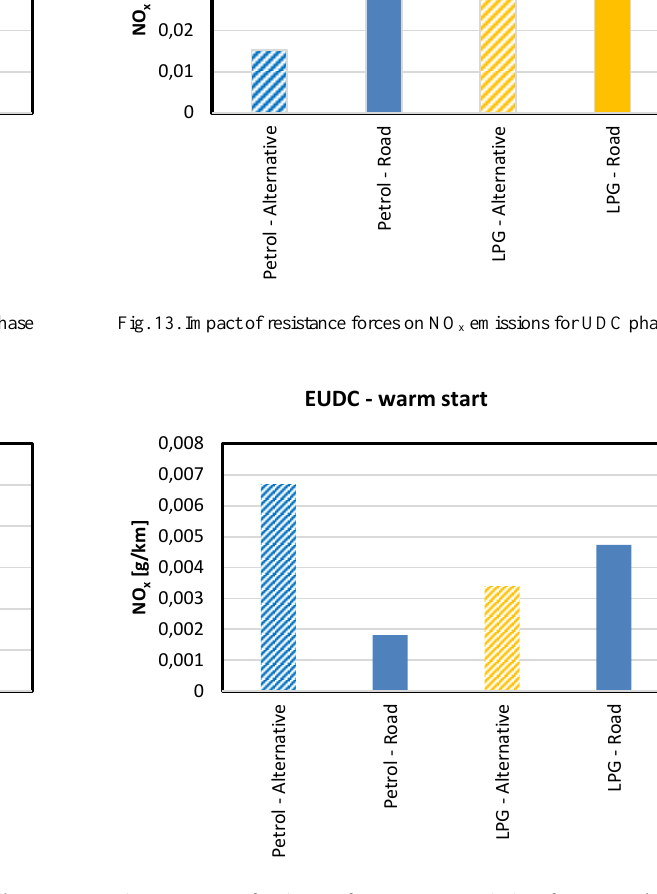
Fig. 11. Impact of resistance forces on CO emissions for EUDC phase